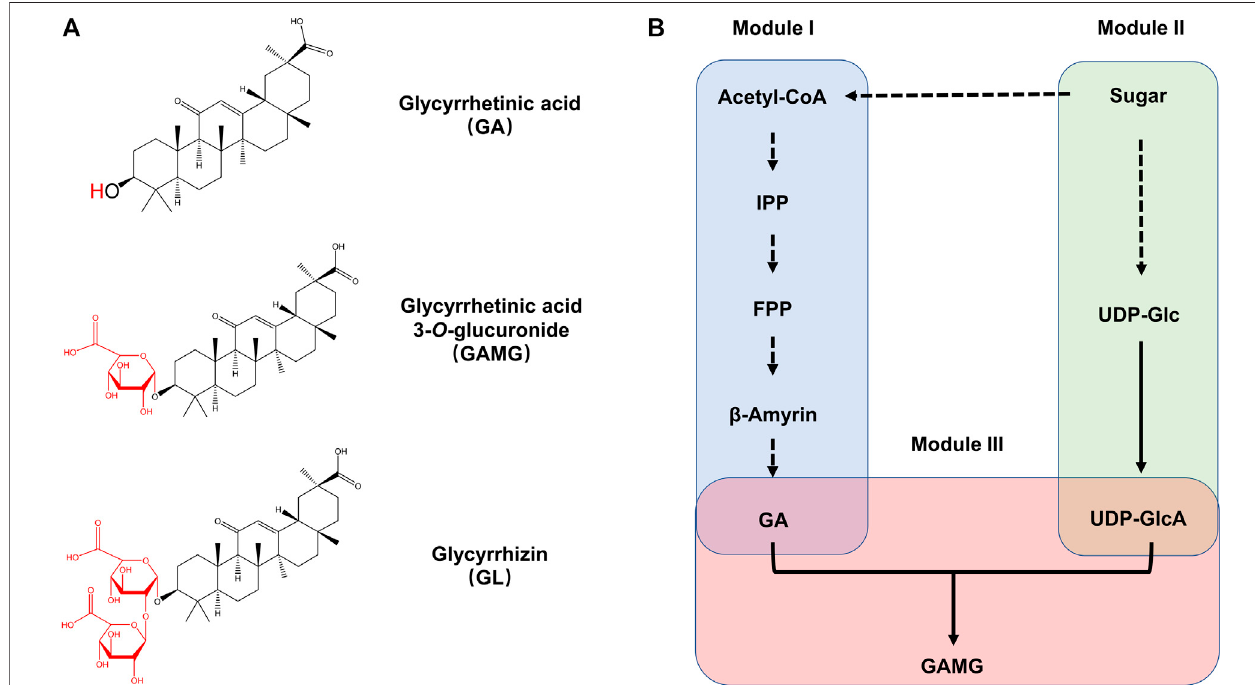
FIGURE1| ThebiosyntheticpathwayofGAMG. (A) ChemicalstructureofGA,GAMG,andGL. (B) MetabolicpathwayforGAMGsynthesisin S.cerevisiae .GAMG was synthesized from GA and UDP-GlcA by UGTs. The whole GAMG biosynthetic pathway was divided into three functional modules: the GA Module (Module I), the UDP-GlcA Module (Module II), and the glycosylation Module (Module III). IPP: isopentenyl pyrophosphate; FPP: farnesyl diphosphate; GA: glycyrrhetinic acid. GAMG: glycyrrhetic acid 3-O-mono- β -d-glucuronide; GL: glycyrrhizin; UDP-Glc: uridine diphosphate-glucose; UDP-GlcA: uridine diphosphate glucuronic